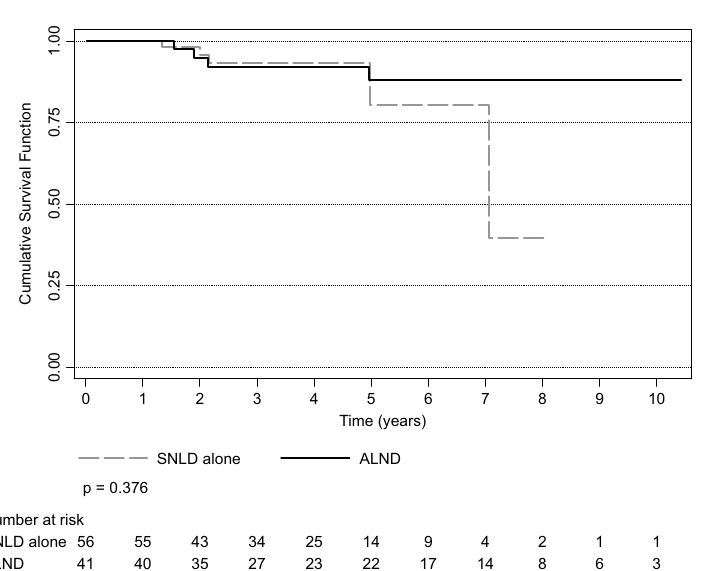
Figure 3. Overall survival over time in patients with breast cancer undergoing ALND or SLND alone. SLND sentinel lymph node dissection, ALND complete axillary lymph node